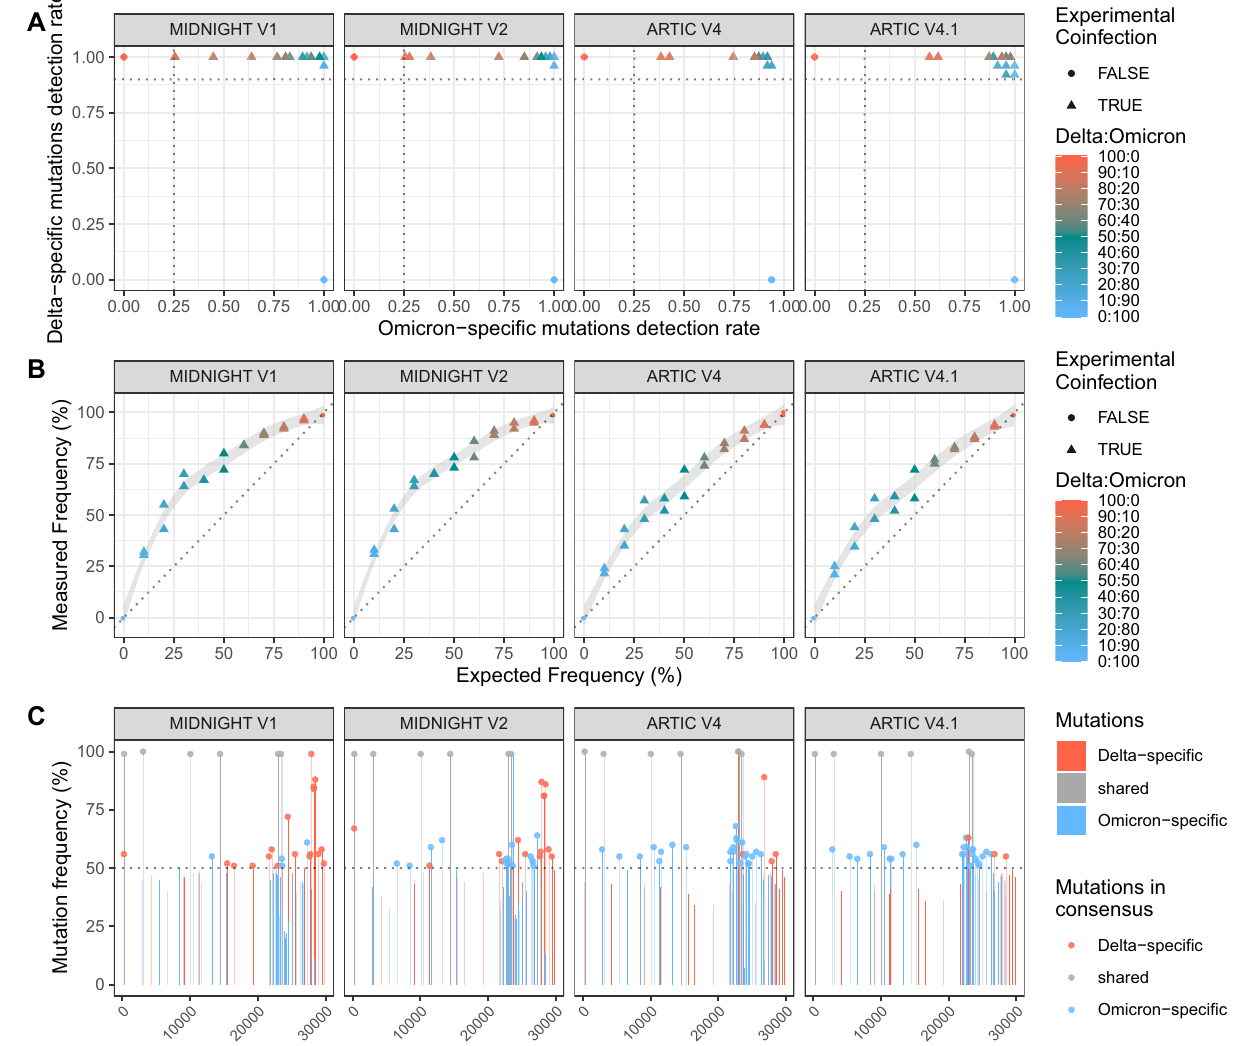
Fig. 1 | Evaluation of 4 primer sets for WGS of Delta:Omicron mixes: Midnight V1, Midnight V2, ARTIC V4 and ARTIC V4.1. Eleven mixes of Delta: Omicron isolates with different proportions were extracted and sequenced in duplicate. A Detection rate of Delta- and Omicron-speci fi c mutations. These detection rates are de fi ned as the number of Delta- or Omicron-speci fi c variants found in each sample (as minor or major allele) out of the total number of Delta- or Omicron- speci fi c variants based on covariants.org. Horizontal line (Delta-speci fi c mutation ratio)at0.9and verticalline(Omicron-speci fi cmutationratio)at0.25discriminate co-infections from pure isolates. B Frequency of the Delta variant was measured using the median of covered allele frequencies of Delta-speci fi c mutations and